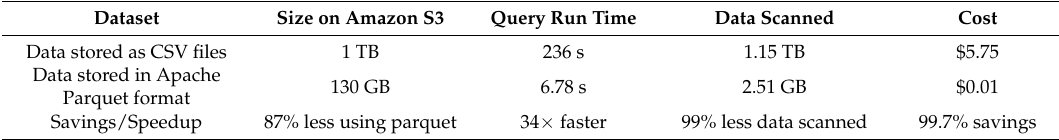
Table 3. Savings and speedup with Apache Parquet [30].